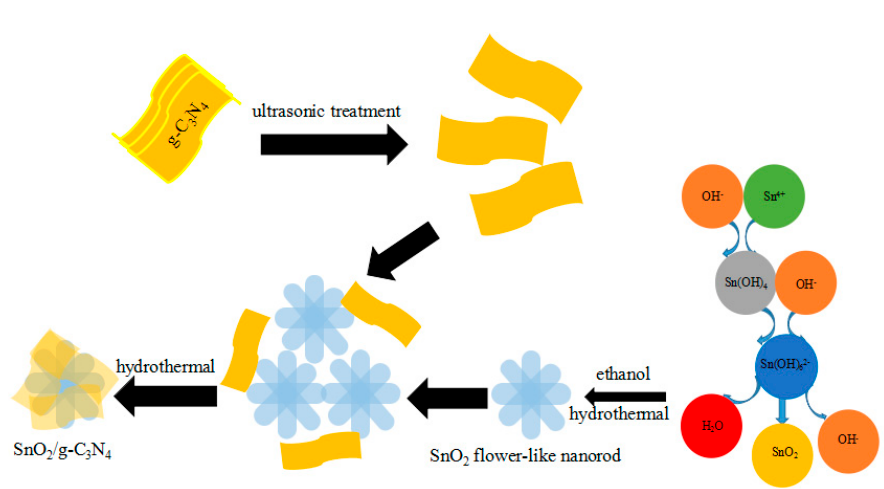
Figure 9. The schematic diagram of the synthesis of the g-C 3 N 4 nanosheets decorated SnO 2 flower-like nanorods.